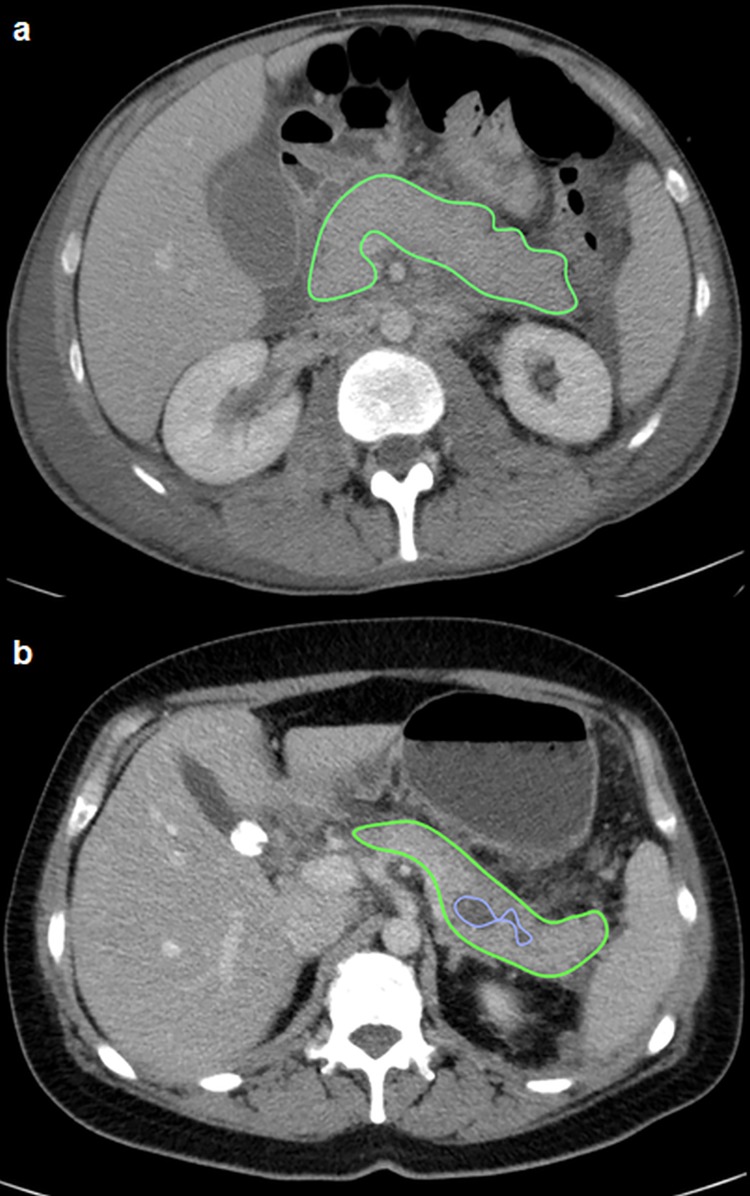
Volumetry of the pancreatic parenchyma of a 56-year old male patient with a interstitial edematous pancreatitis (a) and a volumetry of the pancreatic parenchyma and intrapancreatic necrosis in a 48-year old male patient with necrotizing pancreatitis (b). The pancreatic tissue border is delineated by green colour (a+b), whereas the intrapancreatic necrosis is delineated by blue colour (b).